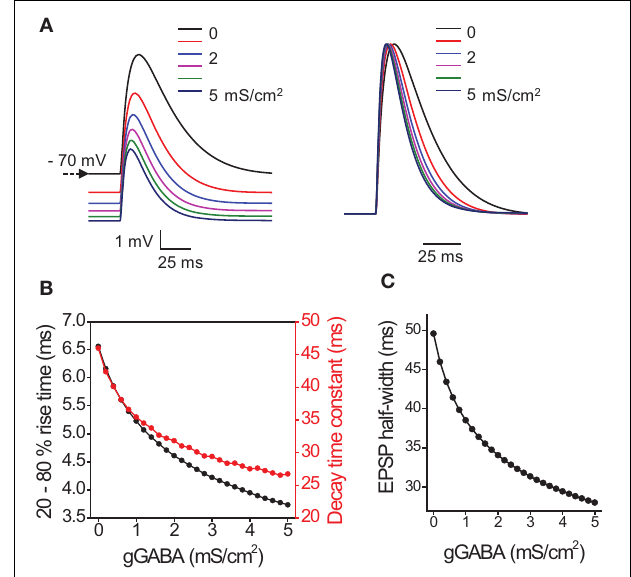
FIGURE 3 | Effect of tonic GABA A conductances on the timecourse of EPSP in model pyramidal neuron. (A) Sample EPSPs color coded for the magnitude of tonic GABA A conductance (0–5mS/cm 2 with step 1mS/cm 2 ). Left , EPSPs without normalization. Note hyperpolarizing shift in membrane potential produced by tonic GABA A conductance. Right , normalized EPSPs. Note acceleration of rise and decay times. (B) Summary data for the change in EPSP 20–80% rise time (black circles) and decay time constant (red circles) with tonic GABA A conductance (gGABA). (C) Summary data for the change in EPSP half-width with